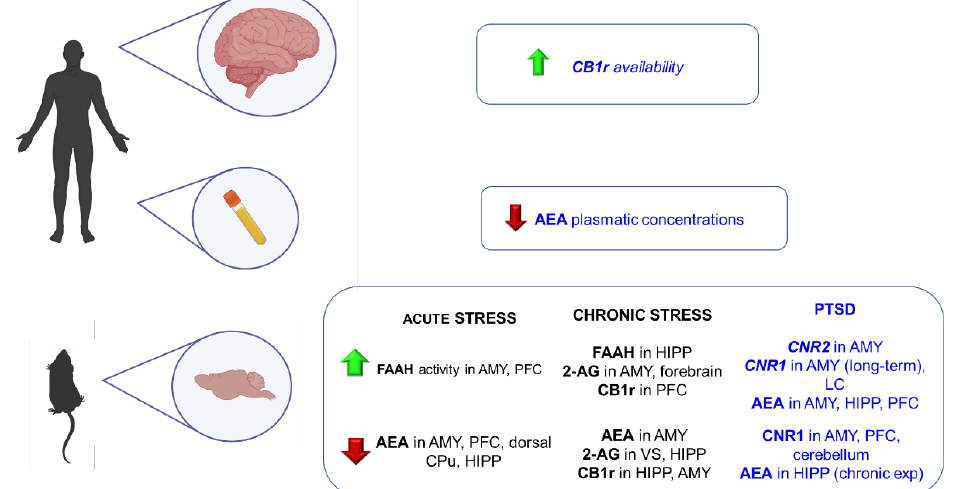
Figure 2. Main findings regarding the alterations of the ECS components in animal models and patients with anxiety and post-traumatic stress disorder. 2-AG: 2-arachidonoylglycerol; AEA: anan- damide; AMY: amygdala; CB1r: cannabinoid receptor 1; CNR1 : gene encoding CB1r; CNR2 : gene encoding CB2r; CPu: caudate putamen; FAAH: fatty acid amide hydrolase; HIPP: hippocampus; PFC: prefrontal cortex; VS: ventral striatum. Note: Anxiety-related studies are in black, and post- traumatic stress disorder studies are in blue.